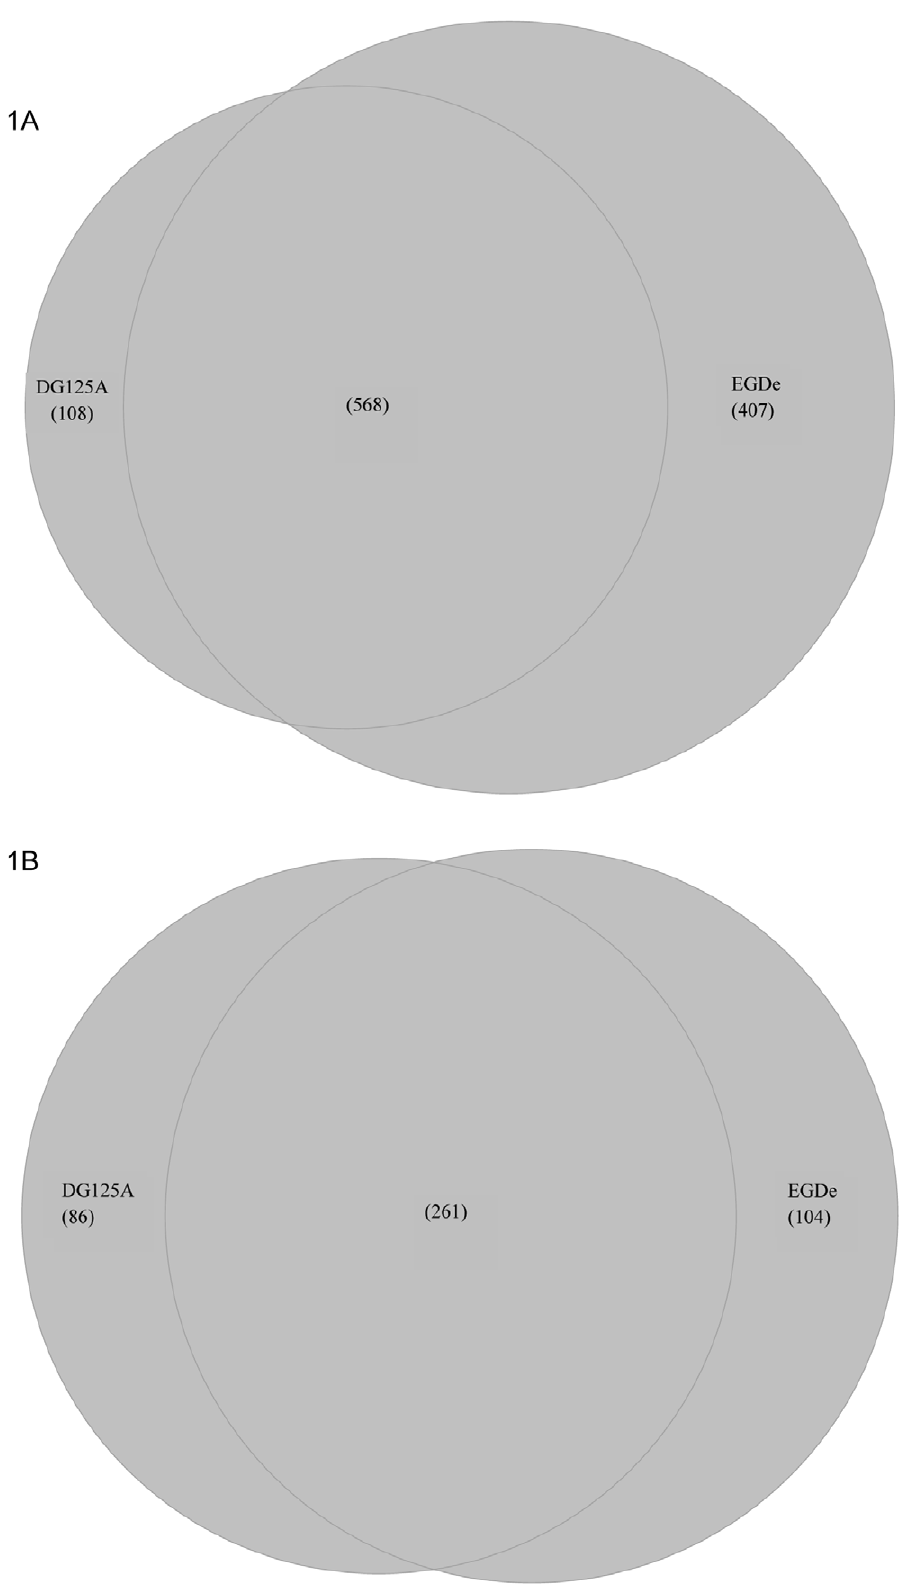
Figure 1. Venn diagrams of the overall number of genes with temperature-dependent variations and represented as specific or common to L.monocytogenes EGD-e and L.monocytogenes DG125A. (A) higher transcript levels at 25 u C; (B) higher transcript levels at 37 u C.